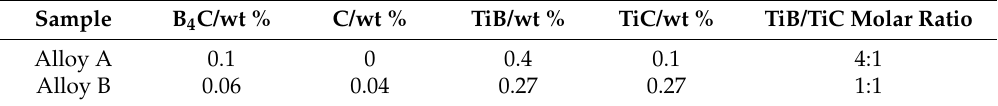
Table 1. Program materials and weight fractions of reinforcements.